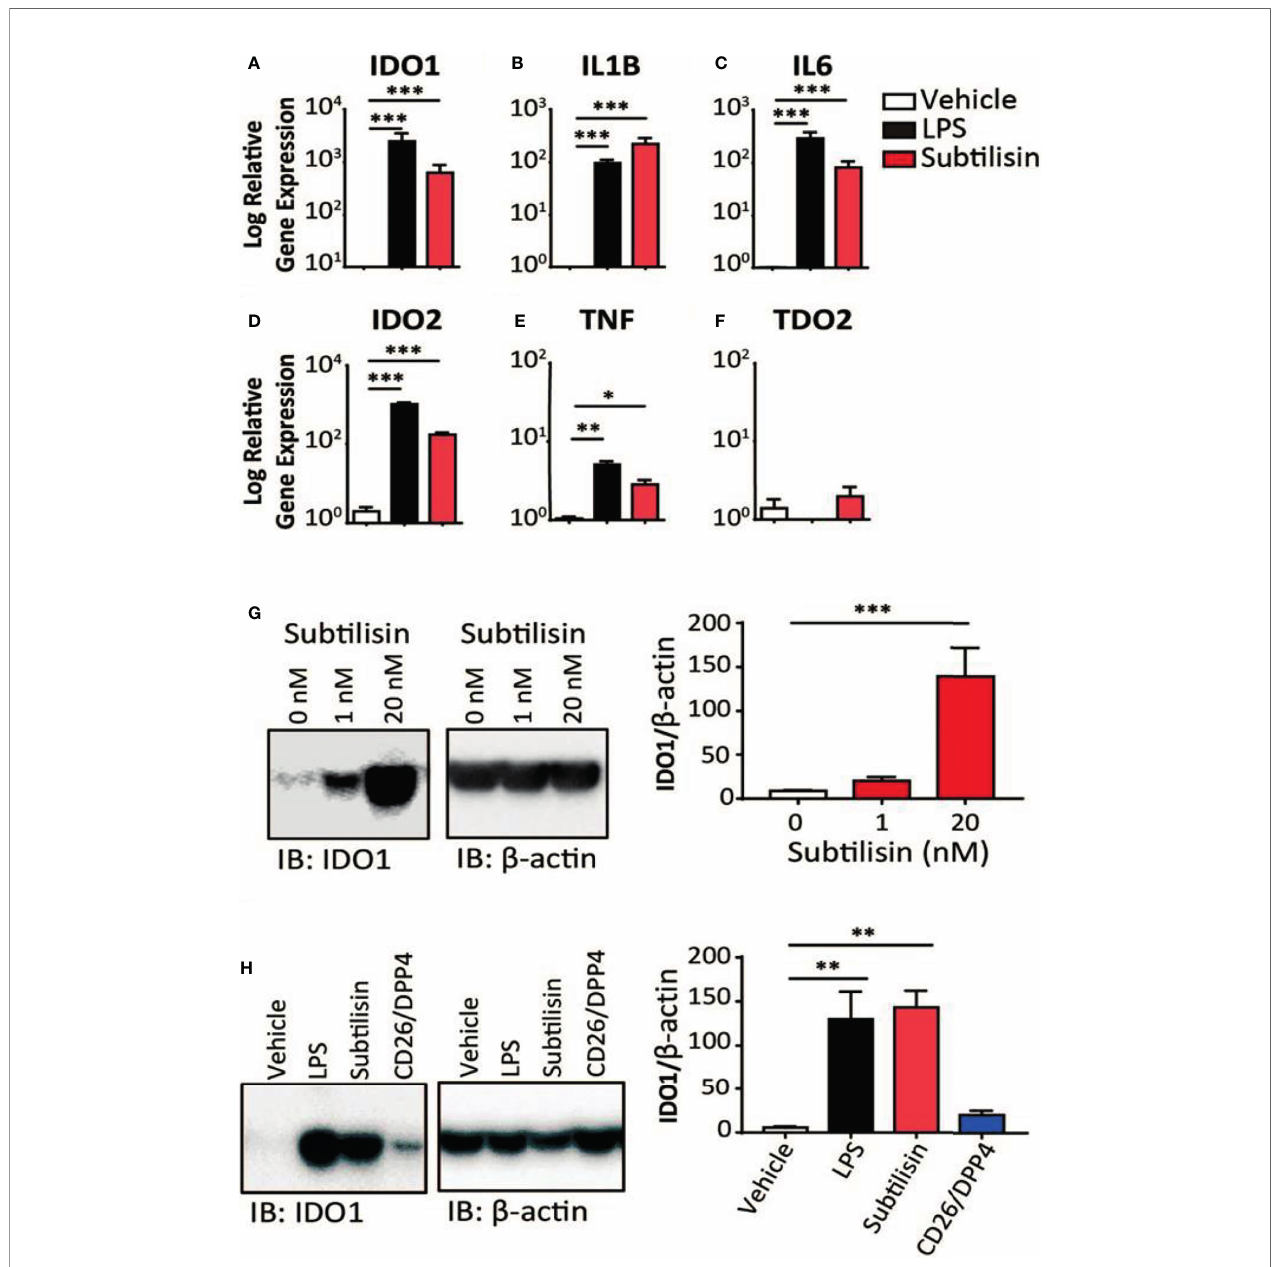
FIGURE 1 | Gene induction by subtilisin. LPS (10 ng/mL) and subtilisin (20 nM; 60 ng/mL) induce the expression of IDO1 (A) , IL1B (B) , IL6 (C) , IDO2 (D) , TNF (E) and TDO2 (F) in human monocyte-derived macrophages (MDMs) (logarithmic scale). (G) Western blots of MDMs from three different donors shows the expression of IDO1 protein is also induced at 1 nM or 20 nM subtilisin; the bar chart shows the quanti fi ed blot density as the ratio of IDO1 to b -actin. (H) CD26/DPP4 induces IDO1 but to a lesser extent than LPS or subtilisin; the bar chart shows the quanti fi ed blot density as the ratio of IDO1 to b -actin. Charts show the mean ± s.e.m. for (n ≧ 3 donors). The number of experiments (n) was 3 except panels A (n = 18), B (n = 15), C (n = 12) and F (n = 6). *P < 0.05, **P < 0.01; ***P <